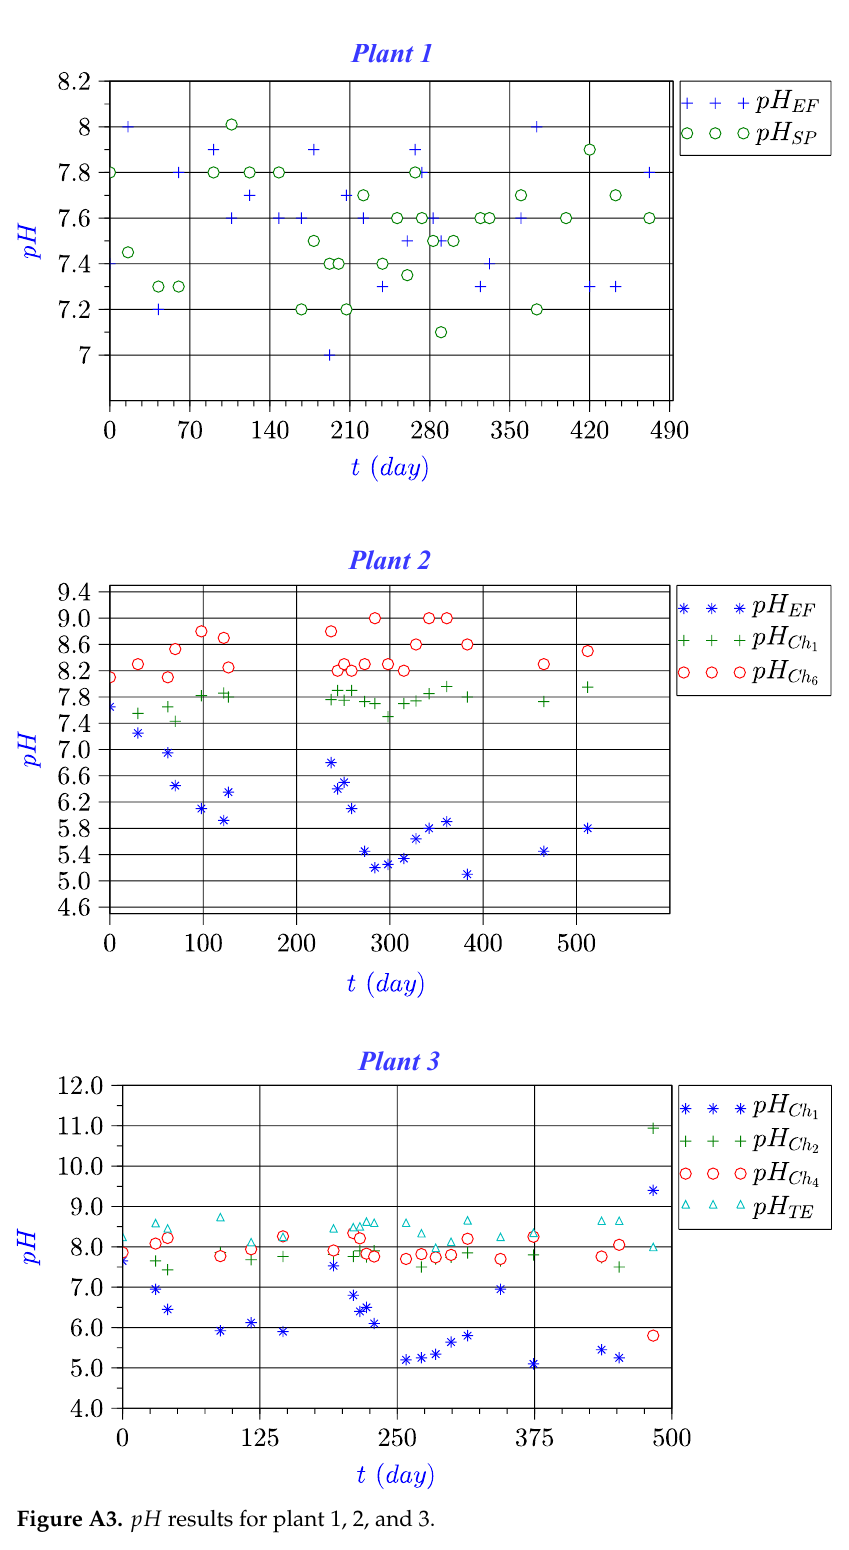
Figure A3. pH results for plant 1, 2, and